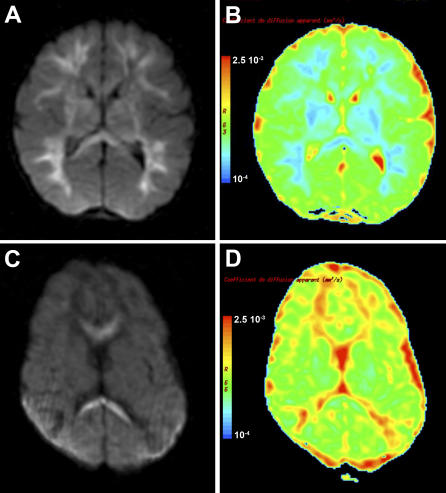
Representative MRI Findings in Neonatal Chikungunya Encephalopathy Cases Observed during the First Chikungunya Outbreak in Saint-Pierre, La Réunion, June 2005 to December 2006(A) Day 6 (child A), scattered hyperintensity signals of the white matter involving the corpus callosum, the frontal and parietal lobes on diffusion-weighted imaging (DWI).(B) Day 6 (child A), scattered reduction of the Apparent Diffusion Coefficient (ADC) of the white matter involving the corpus callosum, the frontal and parietal lobes on ADC mapping (in blue).(C) Day 21 (child B), scattered and characteristic hypo-intensity signals of the white matter involving frontal and parietal lobes on DWI (Note that the corpus callosum remains in hyper-signal).(D) Day 21 (child B), scattered increase of the ADC of the white matter involving the corpus callosum, the frontal and parietal lobes on ADC mapping (in red).